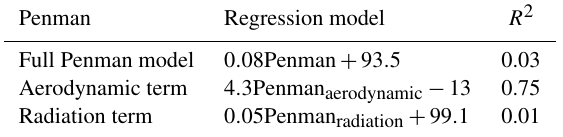
Table 3. Regression analysis between observed open water evapora- tion and estimated evaporation using Penman’s model, also broken down into the two individual terms of Penman’s model, i.e. the aero- dynamic and radiation term. Analysis is performed for the summer period in 2019 using hourly observations from